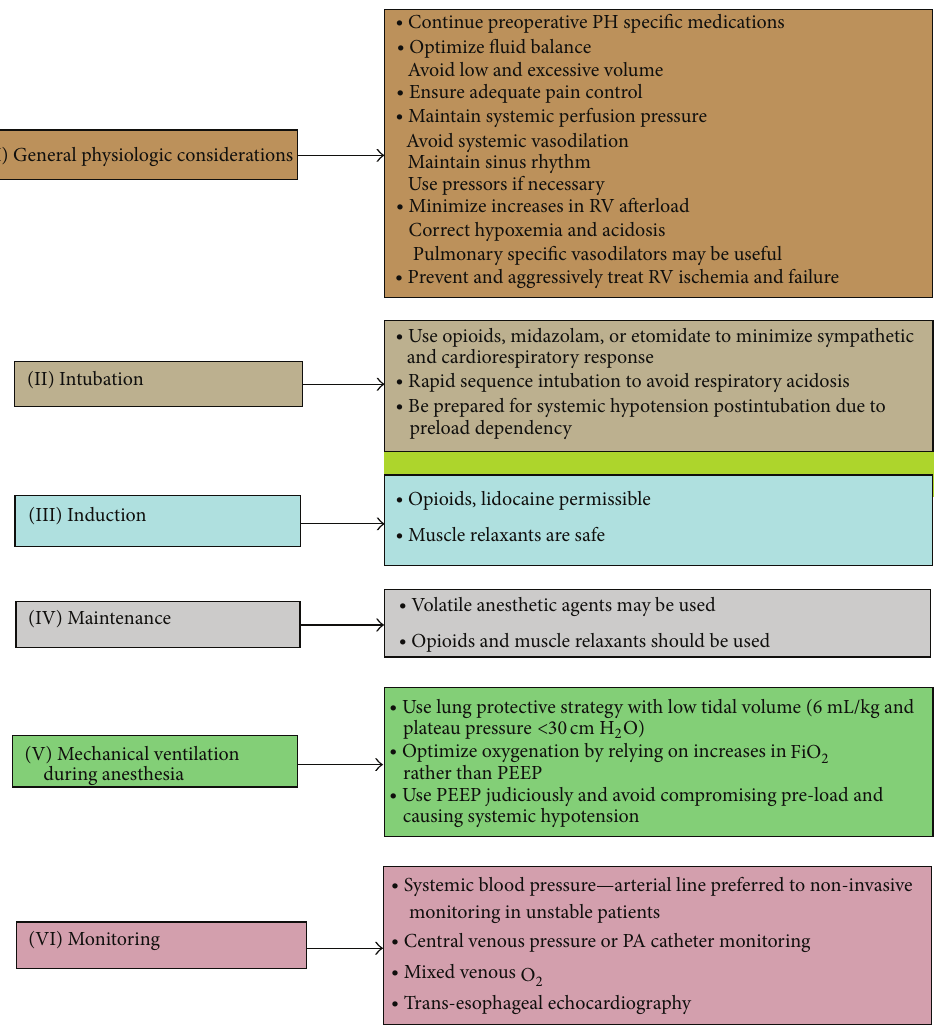
Figure 1: Intraoperative and postoperative management in PH patients with known PH. PA: pulmonary artery (adapted from reference